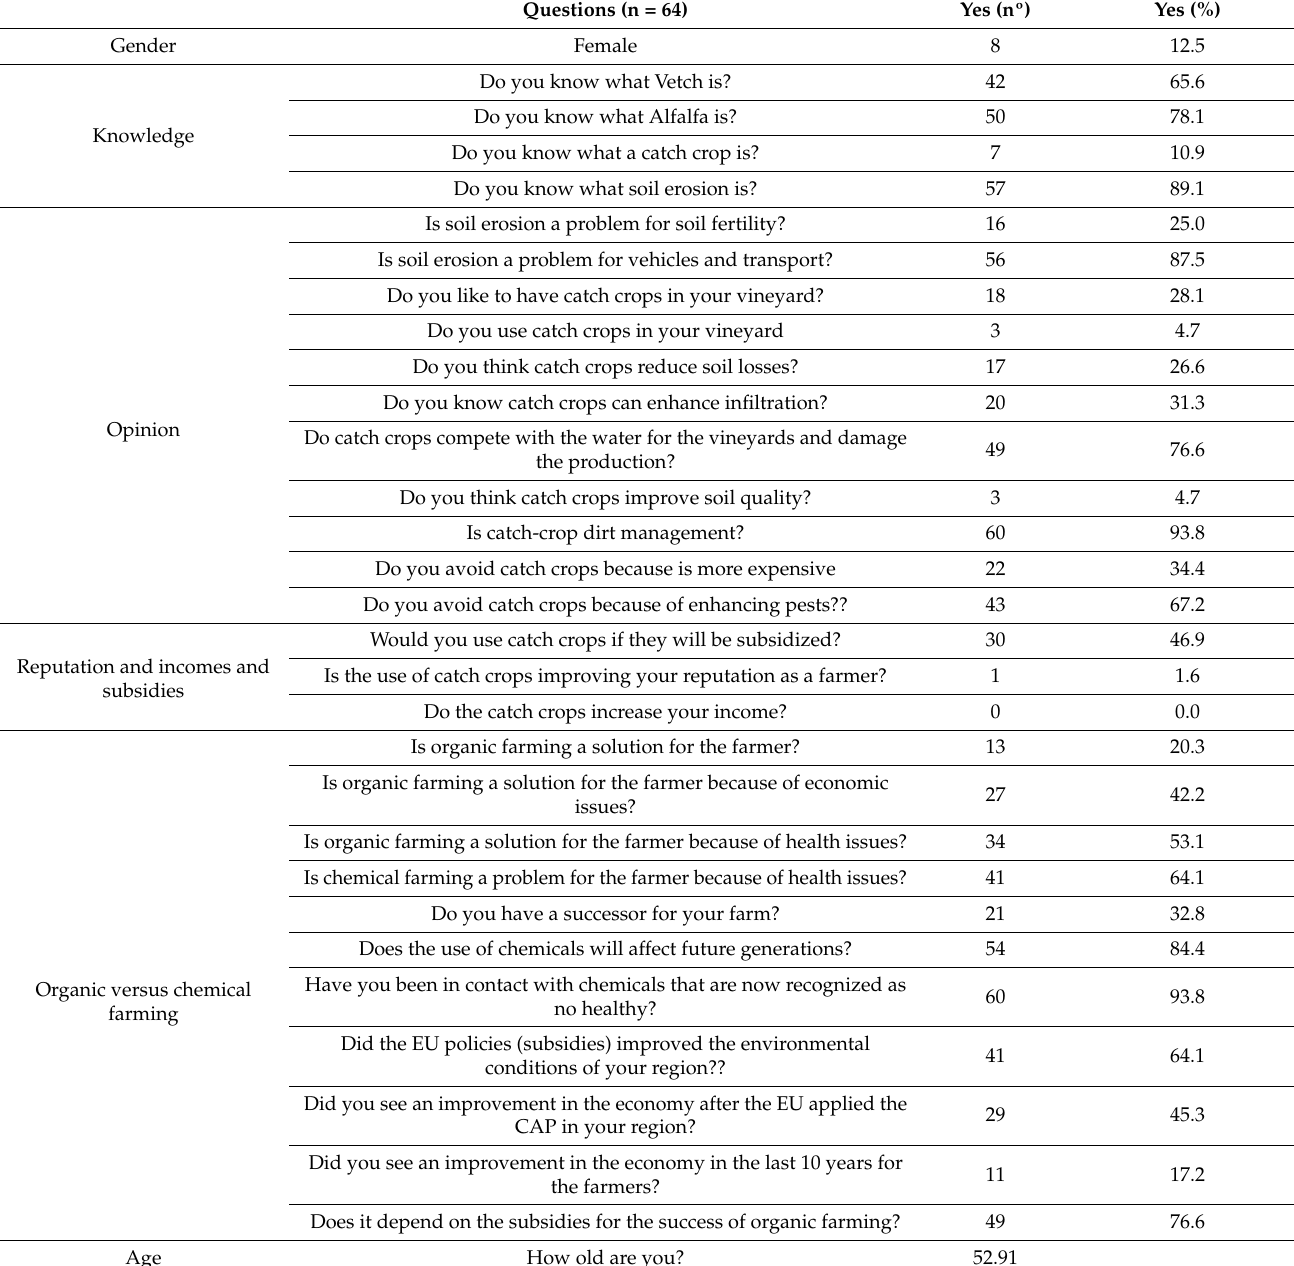
Table 1. Farmer’s knowledge and opinions from survey responses of farmers (n = 64)